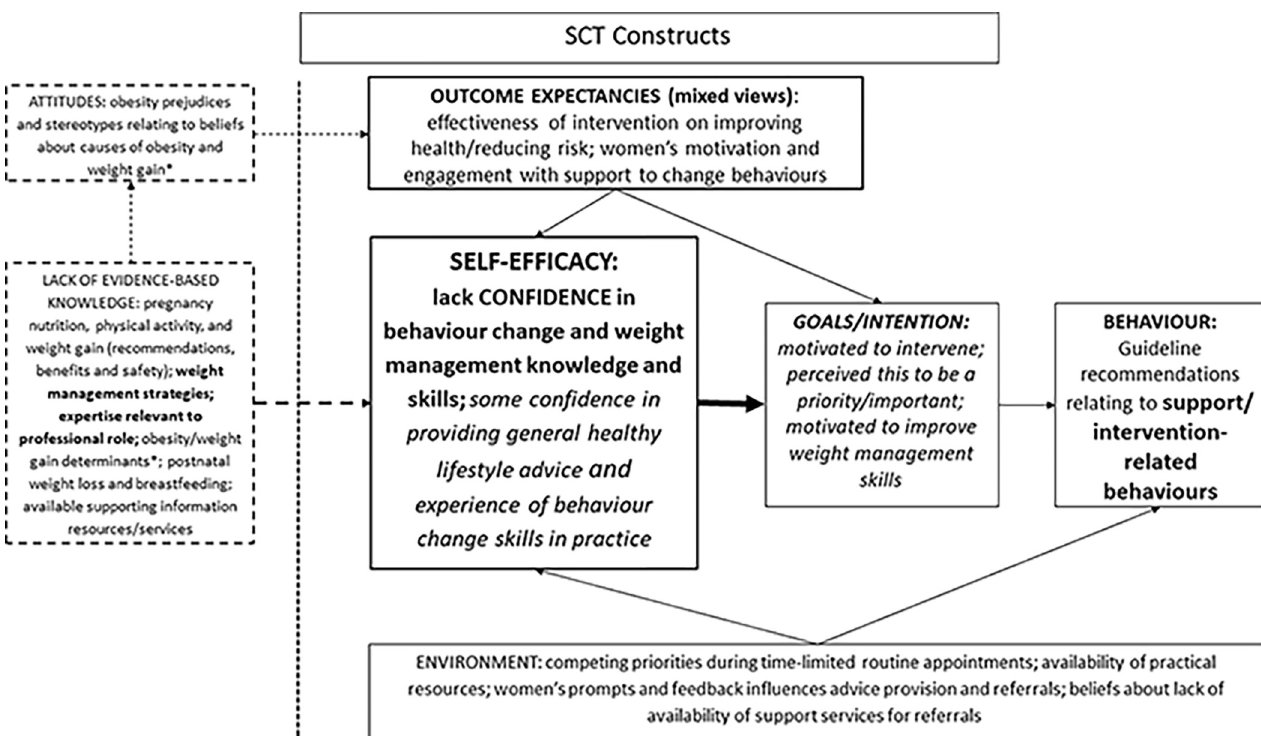
Fig 3. SCT theoretical model for implementation of guideline recommendations for weight management in pregnancy: Support/intervention-related behaviours. SCT = social cognitive theory. Self-efficacy, outcome expectancies, goals/intentions and environment are SCT constructs relating to behaviours. Knowledge and attitudes were identified as an important additional construct in the evidence base having an influence on self-efficacy and outcome expectancies. Bold and larger font size represent the key barriers to practice. Italics font represents facilitators to practice.